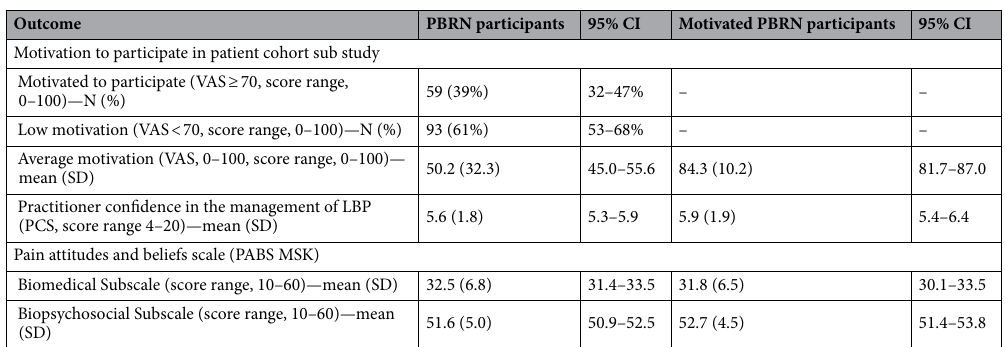
Table 3. Primary clinical and primary feasibility outcomes. CI confidence intervals, PABS-MSK pain attitudes and beliefs scale-musculoskeletal version, PCS practitioner self-confidence scale, SD standard deviation, VAS visual analog